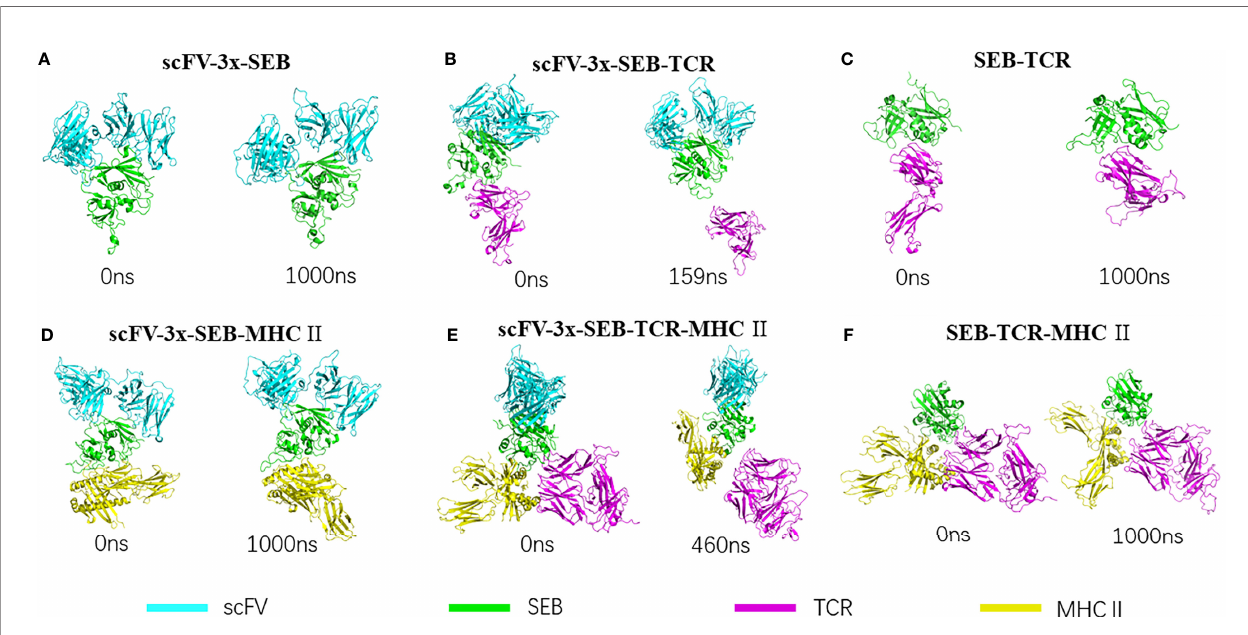
FIGURE 2 | | Bispeci fi c scFV antibody MB102a (scFV-3x) promote disassociation of SEB-TCR, illustrated by starting and ending conformations of four complex simulated. (A) Stable scFV-3x-SEB complex. (B) Binding of MB102a (scFV-3x) break up SEB-TCR b chain interaction. Simulation stopped at 159 ns after TCR b chain disassociated. (C) SEB-TCR b complex is stable throughout 1000 ns simulation. (D) scFV-3x-SEB-MHC II complex is stable throughout 1000 ns simulation. (E) Binding of MB102a leads TCR molecule to dissociate from SEB- MHC II. Simulation stopped at 460 ns after TCR b chain disassociated. (F) SEB-MHC II complex is stable throughout 1000 ns